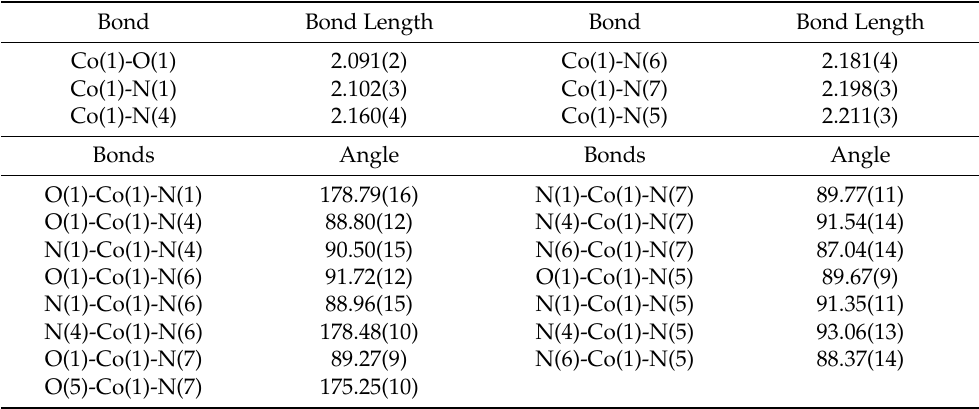
Figure 2. X-ray structure of 1 drawn at 50% probability level for thermal ellipsoids. The labels of the aromatic and aliphatic protons are not depicted for better clarity. aromatic and aliphatic protons are not depicted for better clarity. Table 2. Bond lengths (Å) and angles ( ◦ ) of complex 1 Table 2. Bond lengths (Å) and angles (°) of complex 1 .